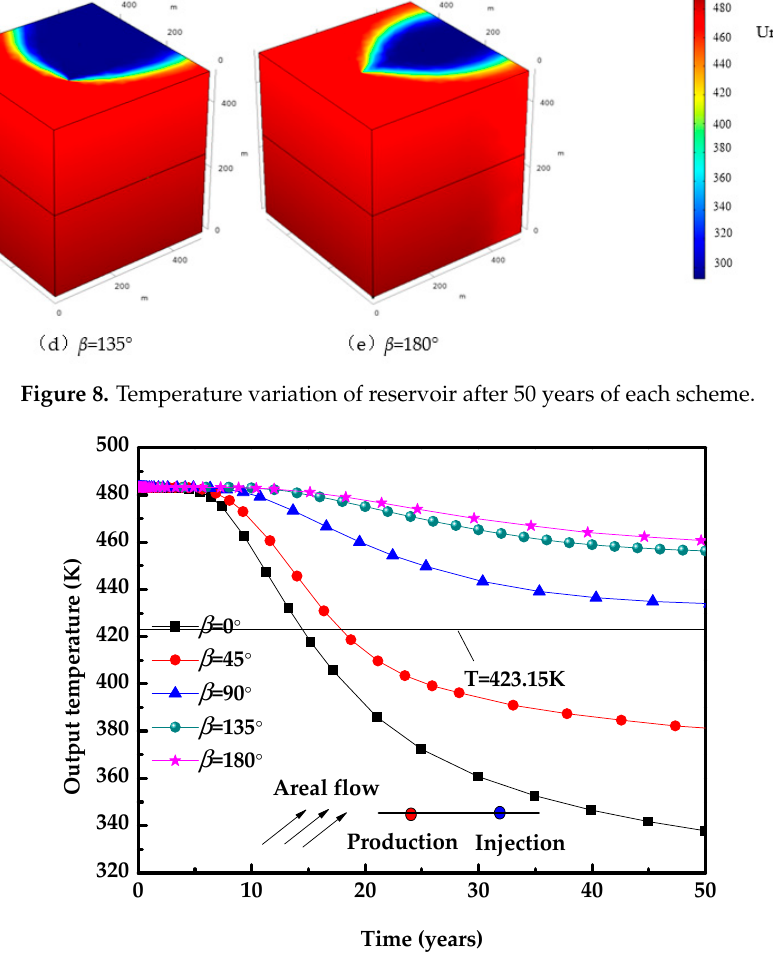
Figure 9. Production well temperature versus time curve under each scheme.